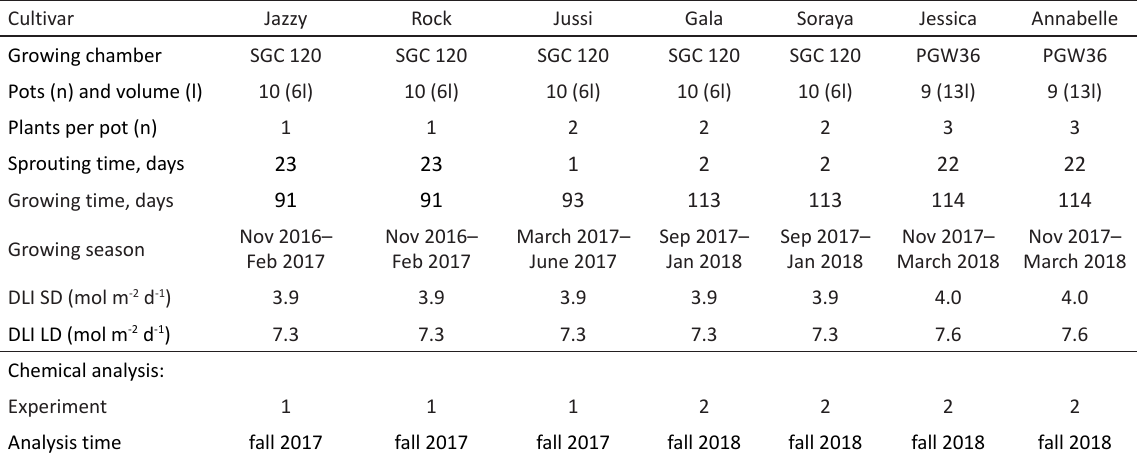
Table 1. Sprouting and growing times and details of the experimental set-up of the cultivars. Temperatures were adjusted to 20 °C for the light period and 14 °C for the dark period, and air humidity was adjusted to 60%. Cultivar Jazzy Rock Jussi Gala Soraya Jessica Annabelle Growing